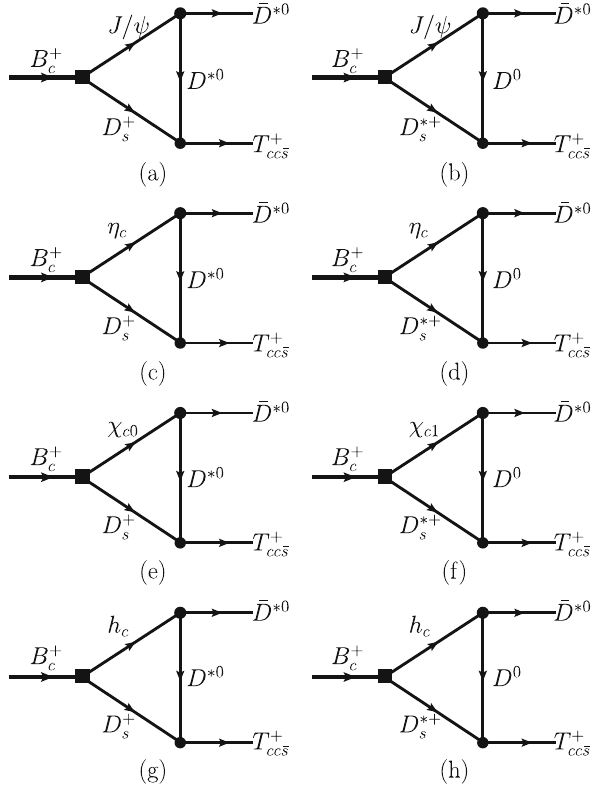
¯ D ∗ 0 via the cc ¯ s